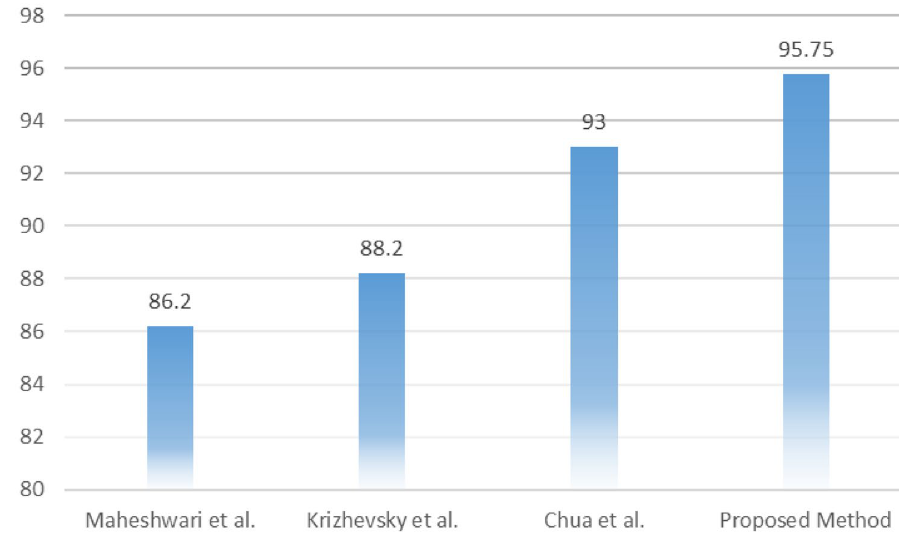
Fig. 8 Accuracy comparison of the